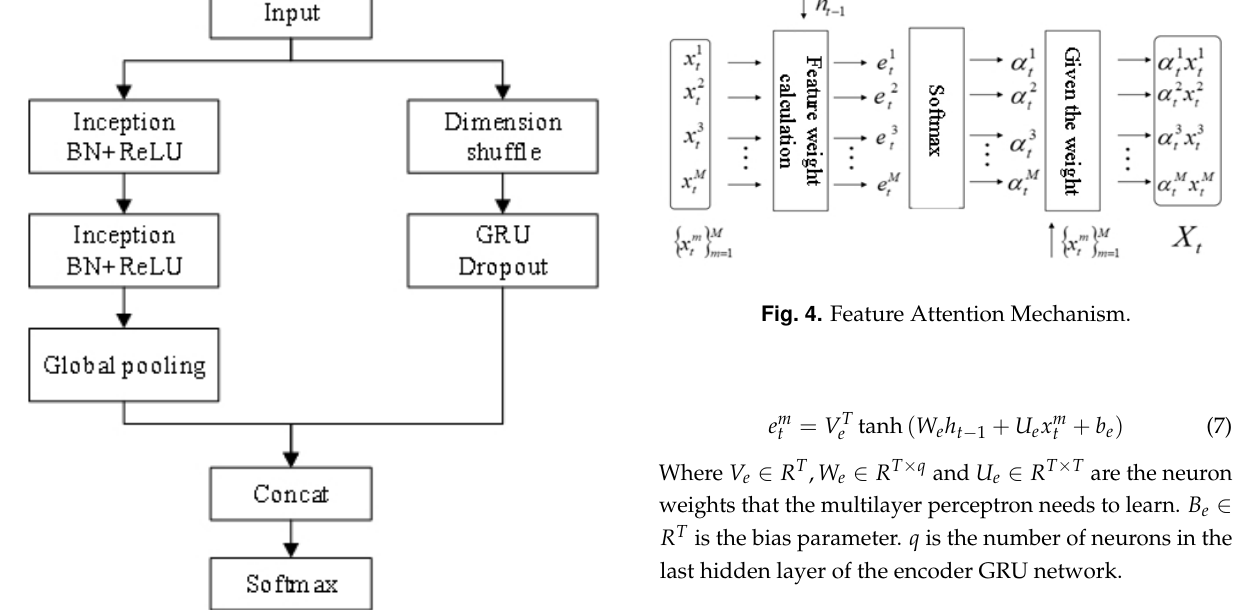
Fig. 3. Proposed model in this paper.